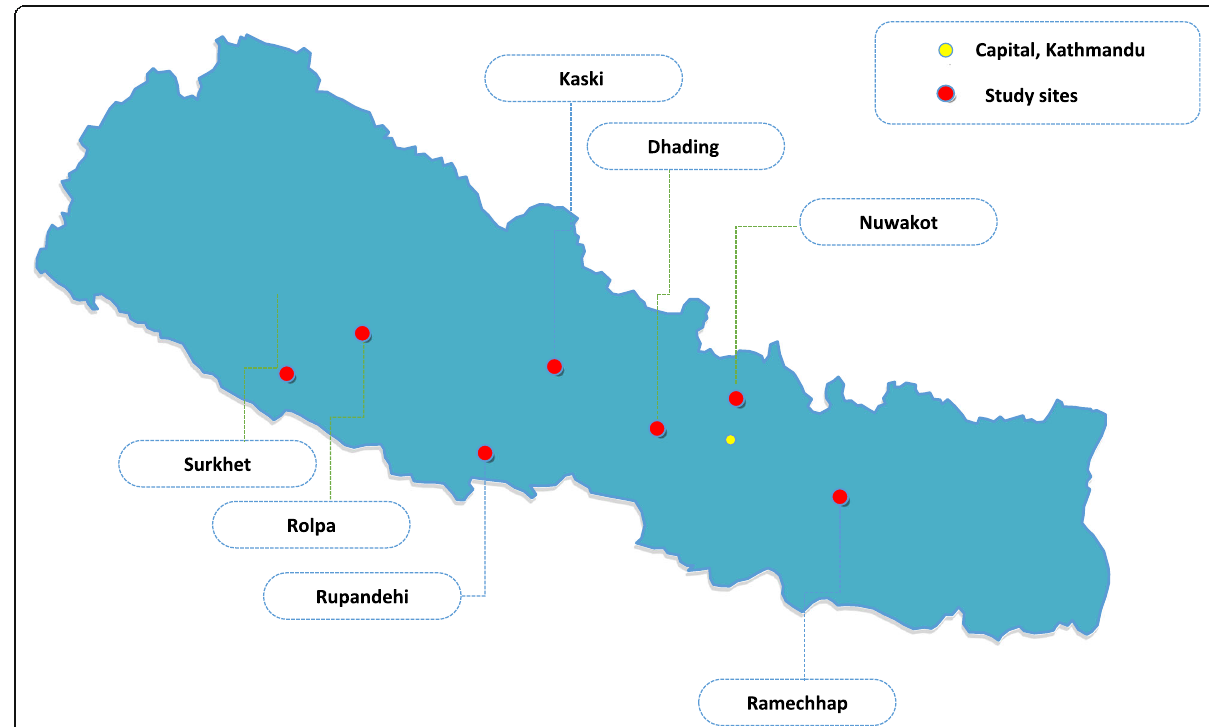
Fig. 1 Location of study sites. Seven Ayurveda Health Centers are selected from Ramechhap, Dhading, Nuwakot, Kaski, Rupandehi, Surkhet and Rolpa